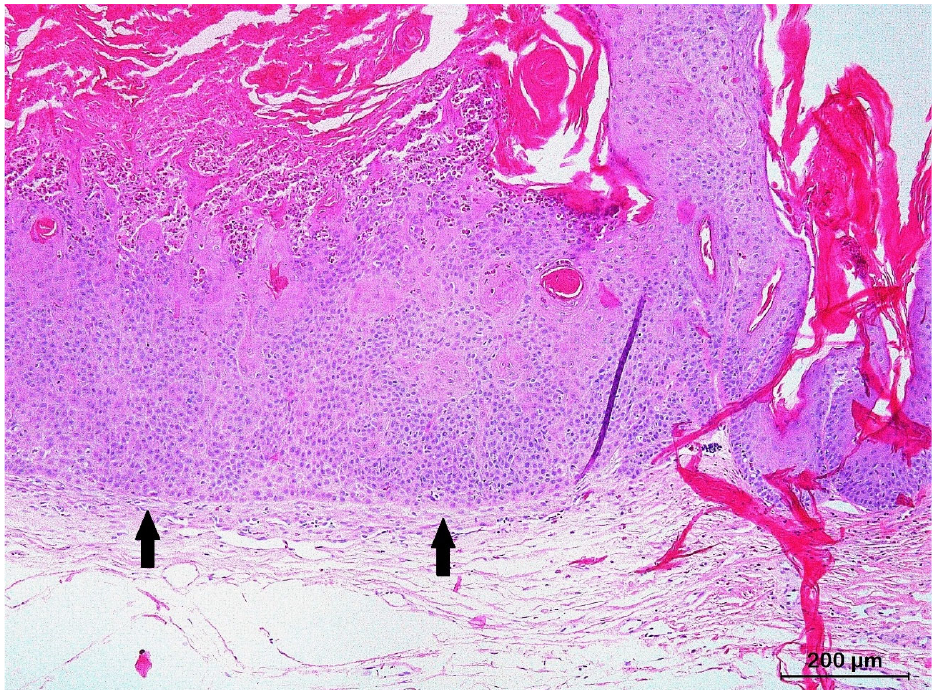
Figure 1. Histological section of a squamous cell carcinoma in situ from the skin of the eyelid of a panther chameleon ( Furcifer pardalis ). Prominent epidermal dysplasia with enlarged and pleomorphic squamous cells replacing the entire thickness of the epidermis can be noted. The basal membrane remains intact (arrows), without invasion of the dermis.